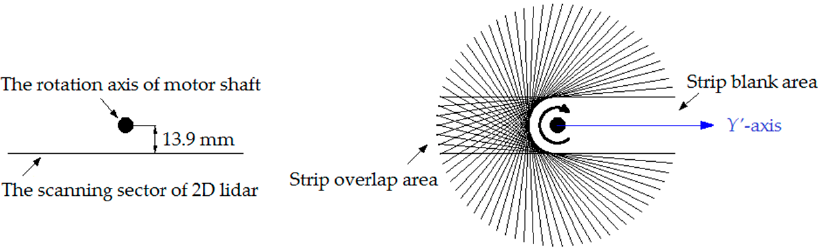
Figure 5. The scanning sector of the 2D lidar does not coincide with the rotation axis of the motor shaft. They are parallel to each other, and the distance between them is 13.9 mm. This design can collect the 3D point cloud with a mark, which can roughly show the position of the motor shaft at the moment a 3D scan is started, that is, the position of the Y’ -axis of coordinate frame O’-X’Y’Z’ . In our prototype, the scanning sector of the 2D lidar does not coincide with the rotation axis of the motor shaft, and they are parallel to each other, the distance between them is 13.9 mm (as shown in Figure 4). The reason for this design can be explained in Figure